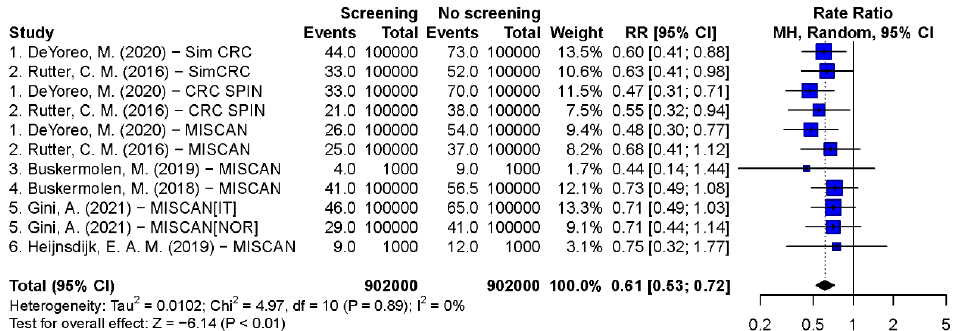
Figure 4. Forest plots of the CRC-specific mortality rate ratio on single FS screening from the age of 50 to 75 [20,21,24,25,29,42].